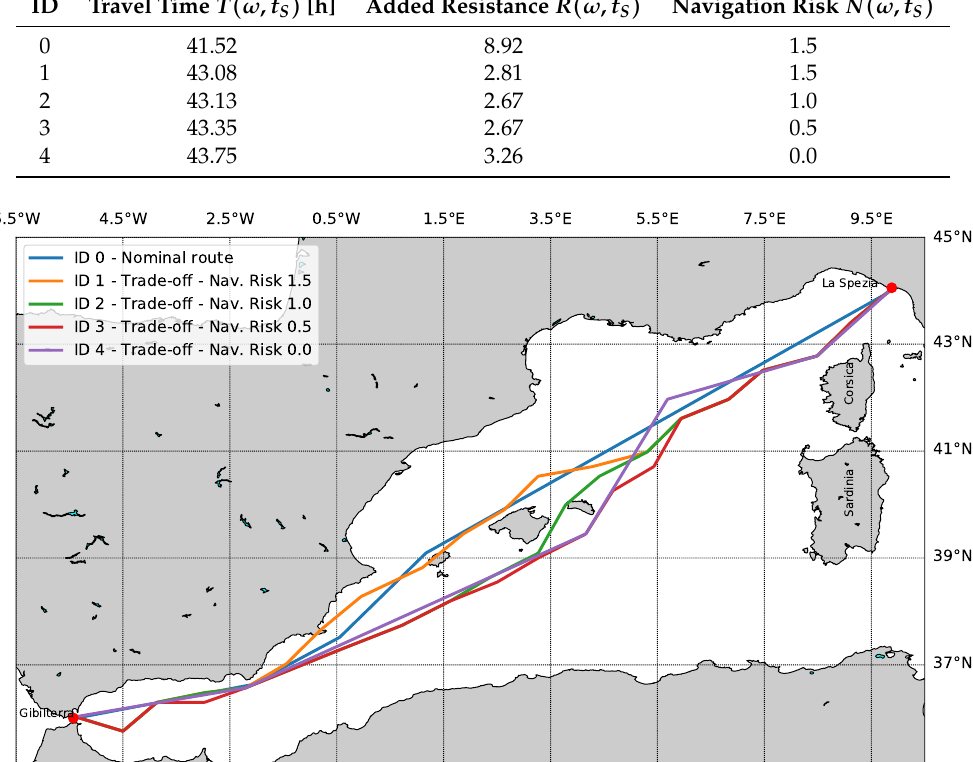
Table 4. Costs value for the nominal route (ID = 0) and the trade-off routes (IDs = 1–4).